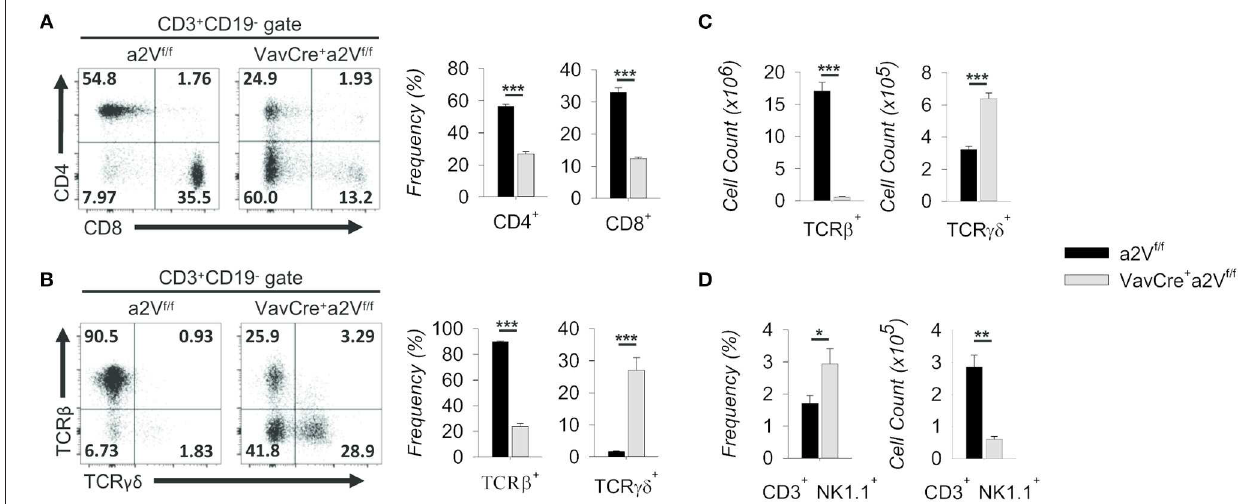
FIGURE 4 | Characterization of splenic T cell compartment in Vav Cre a2V fl / fl mice. (A) Flow cytometric analysis and quantification of CD3 + splenocytes on the basis of CD4 and CD8 surface expression. (B) Flow cytometry and quantification of CD3 + gated splenocytes on the basis of TCR β and TCR γδ surface expression. (C) Absolute numbers of TCR β and TCR γδ populations in a2V fl / fl and Vav Cre a2V fl / fl spleens. (D) Frequency and absolute numbers of NK1.1 + splenocytes within the CD3 + CD4 − CD8 − gate. Numbers in flow plots represent the frequency of each gate or quadrant. Numeric data represents means ± SEM. Unless otherwise noted, all data are representative of at least three independent experiments with n ≥ 3. n.s., no significance, * p ≤ 0.05, ** p ≤ 0.01, *** p ≤